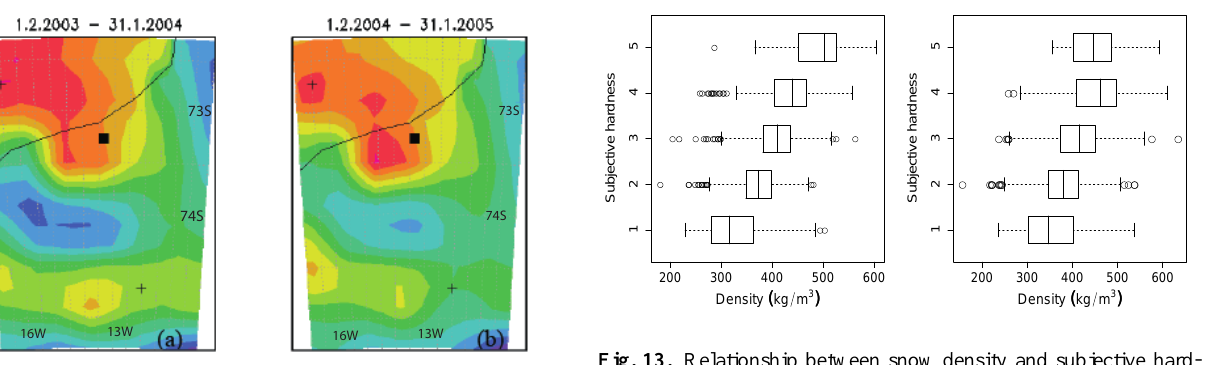
Fig. 13. Relationship between snow density and subjective hard- ness along the transect sampled during summer 2003/2004 (left) and 2004/2005 (right). See Table 2 for the hardness classes in the y-axis. The vertical line inside the box describes the median for the current class, the box extends from the 25% quartile to 75% quar- tile and the whiskers extend to 1.5 times the inter-quartile range. Outliers are shown as separate